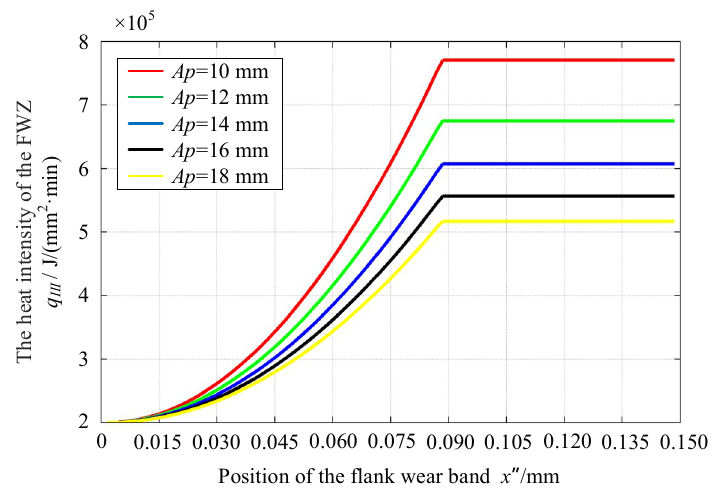
Figure 27. The heat intensity in the FWZ at different milling speeds ( Ap = 10 mm).